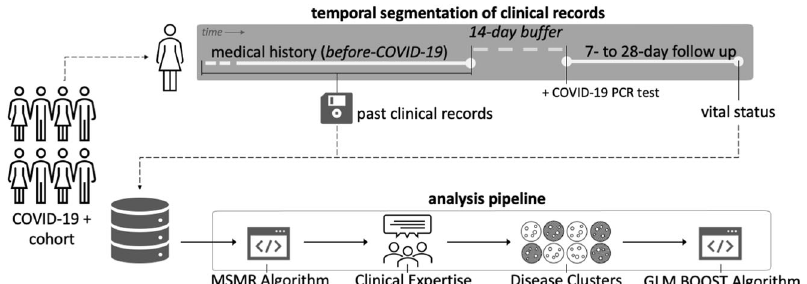
Fig. 5 Temporal segmentation of clinical records and analysis pipeline. The analysis pipeline utilizes longitudinal clinical data with a 14-day buffer before COVID-19